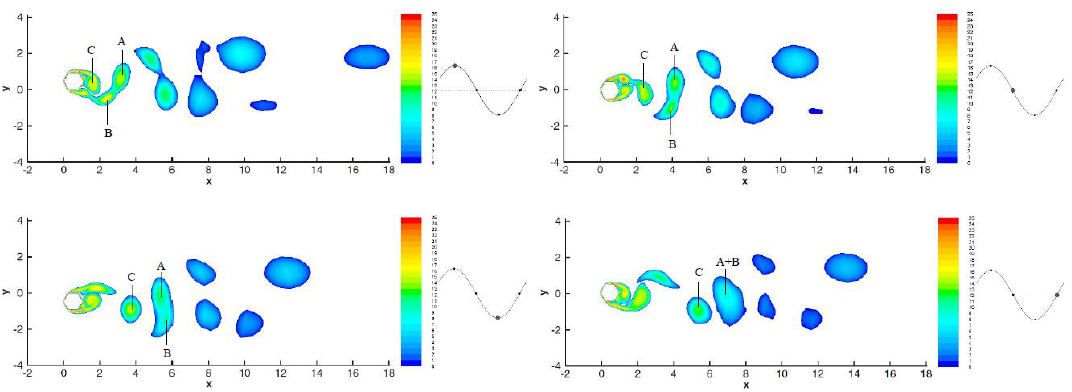
Figure 7. Vorticity contours at four instants in a vibration period of the corner-oriented hexagonal cylinder at Vr = 2.28 at 93.02 < t* < 95.92.